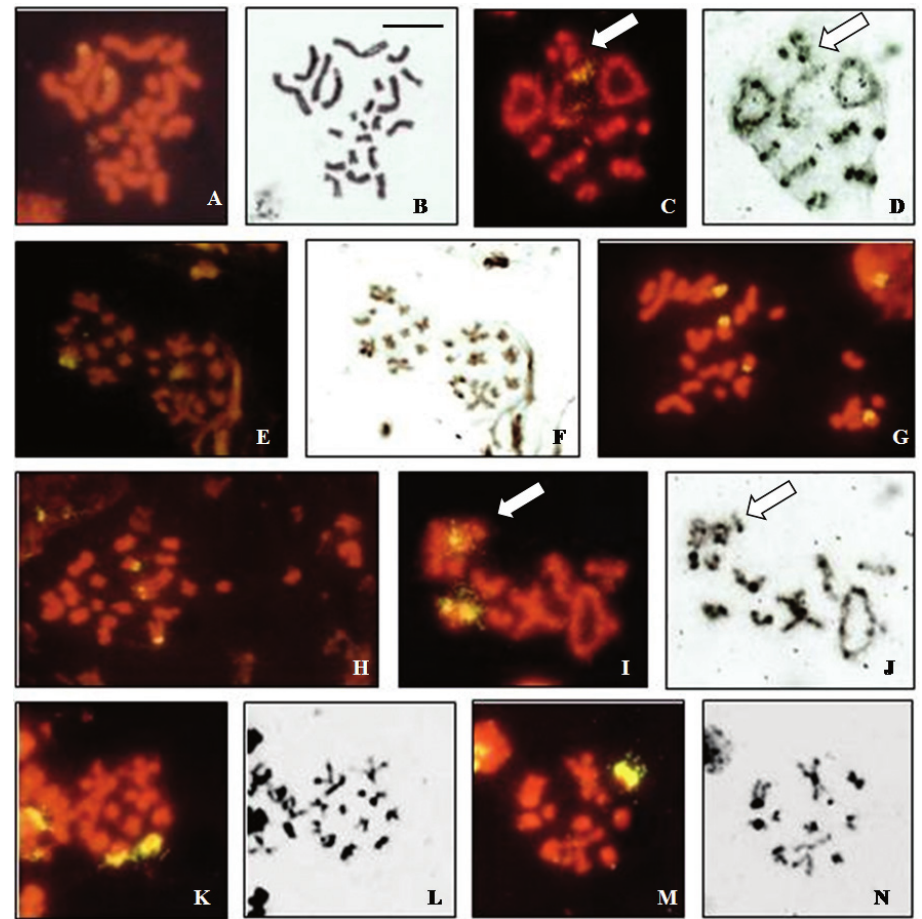
Figure 2a–n. Localization of rDNA clusters in Cicindela , revealed by in situ hybridization of the PCR amplified ribosomal probe to squashed mitotic and meiotic chromosomes. The phase contrast image of some cells is figured to the right of the fluorescence image. a, b Cicindela hispanica , female mitotic meta- phase c, d C. hispanica , male metaphase I plate; n=9+X X Y, e, f C. hispanica , male metaphase II plates, n 1 2 = 9+Y and n = 9+X X , g C. maura , female mitotic metaphase h C. maura , male mitotic metaphase i, j C. 1 2 maura , male metaphase I plate; n=9+X X X Y k, l C. maura , male metaphase II plate (n=9+ X 1 2 3 C. maura , metaphase II plate (n=9+Y). Arrows indicate the sex chromatin. Bar =